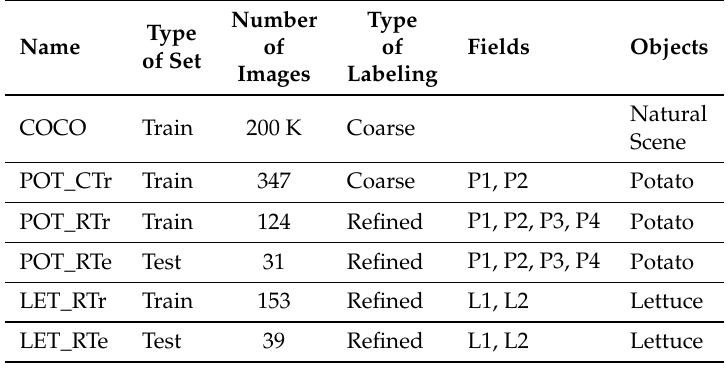
Table 2. Summary of the charateristics of the datasets. Naming convention relies on C for “Coarse”, R for “Refined”, Tr for “Training” and Te for